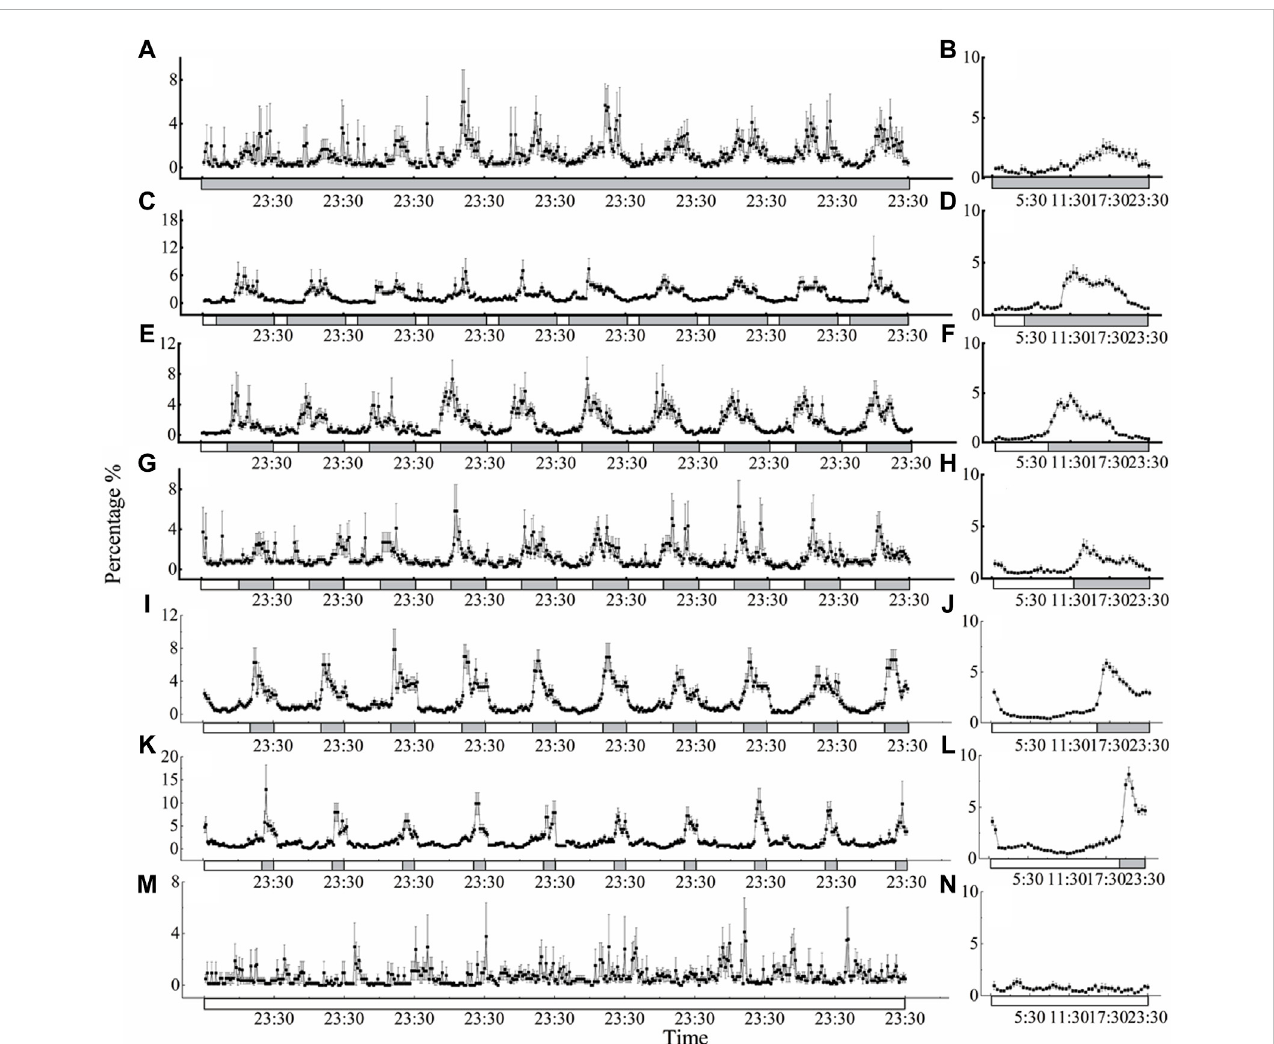
Figure 2 Circadian rhythms oflocomotoractivity of D.helophoroides underdifferentLDcycles atatemperatureof25 ° C.LDcycles: (A, B) 0L/24D; (C, D) 4L/20D; (E, F) 8L/16D; (G, H) 12L/12D; (I, J) 16L/8D; (K, L) 20L/4D; (M, N) 24L/0D. Data (n = 20) shown are the mean ± standard error of the mean (SEM). The percentages in the fi gure indicate the occurrence frequency of single behaviors of individual insects at 30 min various time intervals within 1 day. Black and white bars represent the LD cycle, black = subject night, white = subject